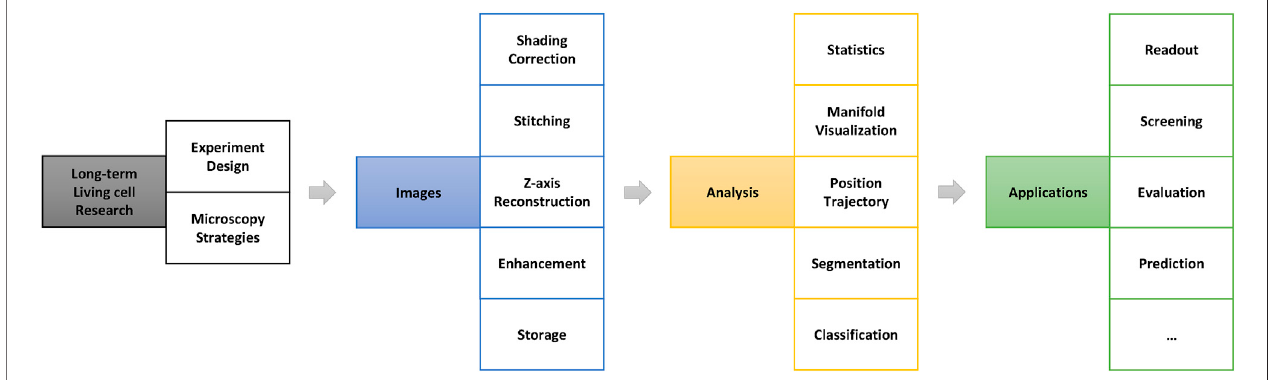
FIGURE 1 | General processing pipeline for long-term live-cell research. The image preprocessing stage (blue part in this fi gure) is very important in the entire research pipeline and directly determines the accuracy and results of the further analysis.